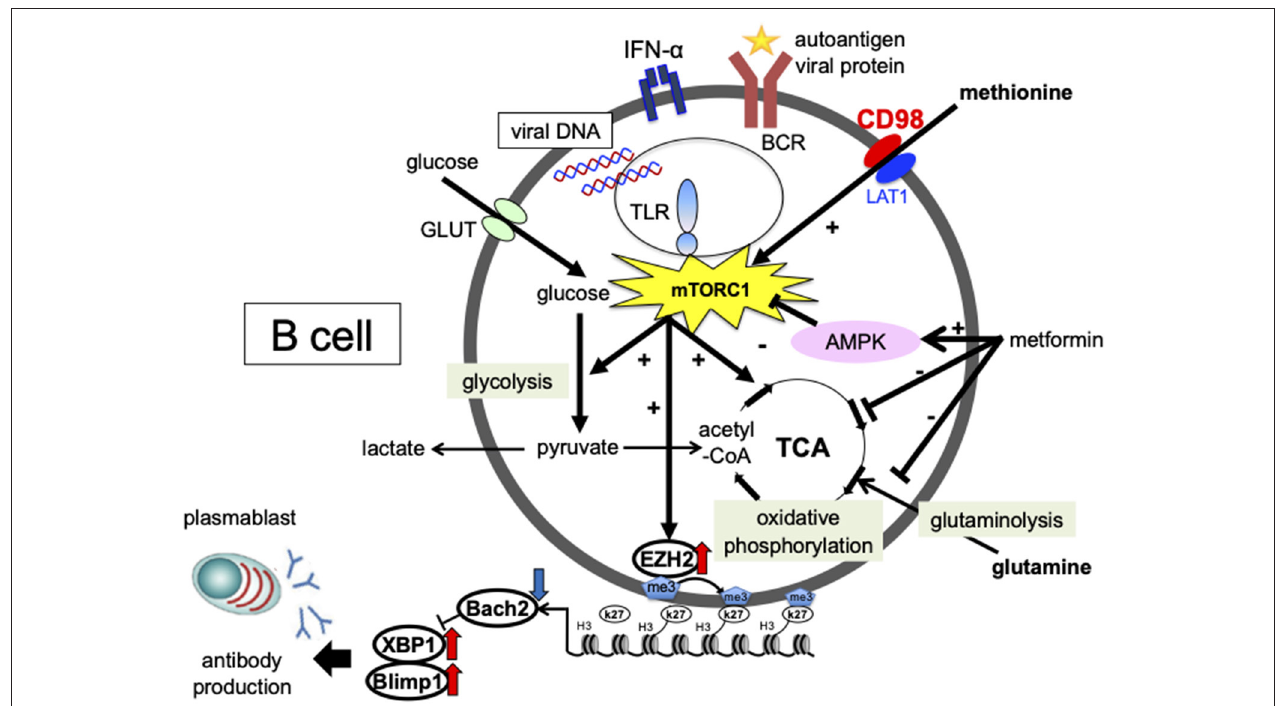
FIGURE 1 | Involvement of cellular metabolism in the process of plasmablast differentiation in SLE. The glucose metabolic pathway consists of the glycolytic system, which converts glucose to pyruvate, and oxidative phosphorylation, which generates energy via the tricarboxylic acid (TCA) cycle. In the mitochondria, pyruvate is converted to acetyl-CoA, which enters the tricarboxylic acid cycle. Energy is also generated by glutamine metabolism. During anaerobic metabolism, pyruvate is converted into lactate. The essential amino acid methionine is strongly committed to plasmablast differentiation. In the presence of methionine, mTORC1 activation induces the expression of the methyltransferase enhancer zeste homolog 2 (EZH2). EZH2 induces H3K27me3 at BTB and CNC homolog 2 (BACH2) loci and suppresses BACH2 expression, leading to the induction of B lymphocyte-induced maturation protein-1 (BLIMP1) and X-box binding protein 1 (XBP1) expression and plasmablast differentiation. Metformin inhibited CpG- and IFN- α -induced glutamine uptake, mitochondrial function, and suppressed plasmablast differentiation. Enhanced cellular metabolism mediated by amino acids, such as methionine and glutamine, is important for plasmablast differentiation, which may be a potential therapeutic target for